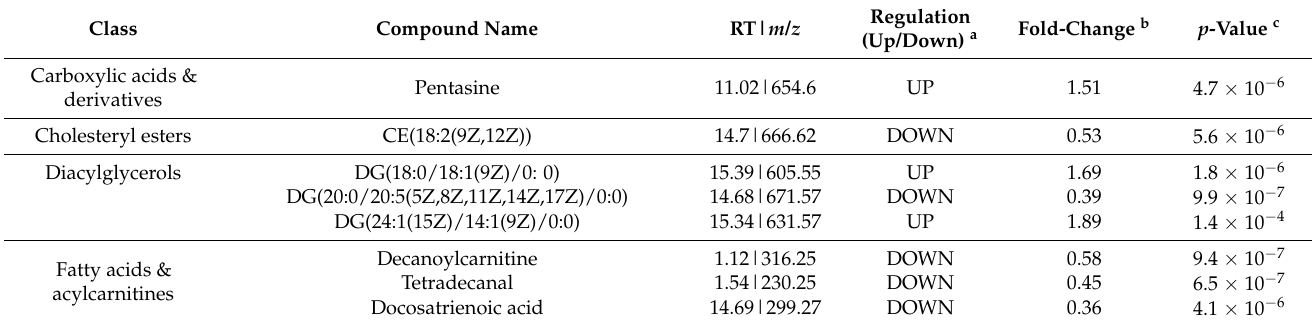
Table 3. List of annotated significantly altered lipidomic